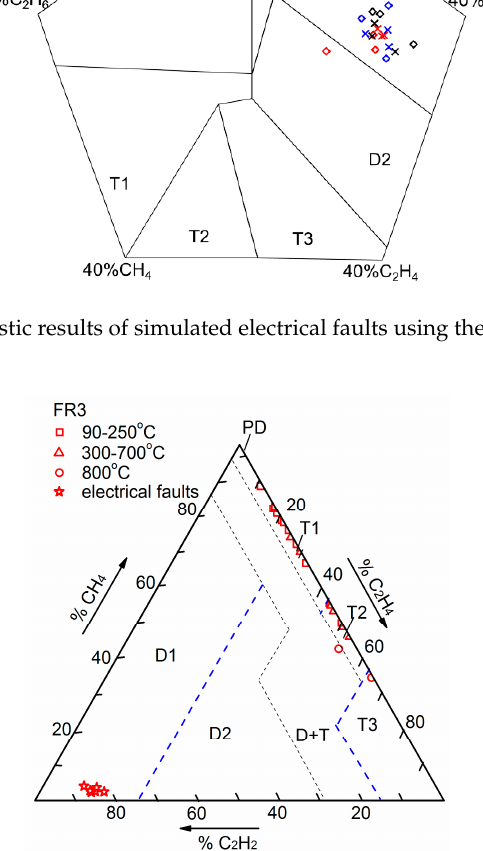
Figure 19. Diagnostic results of simulated electrical faults using the Duval Pentagon.